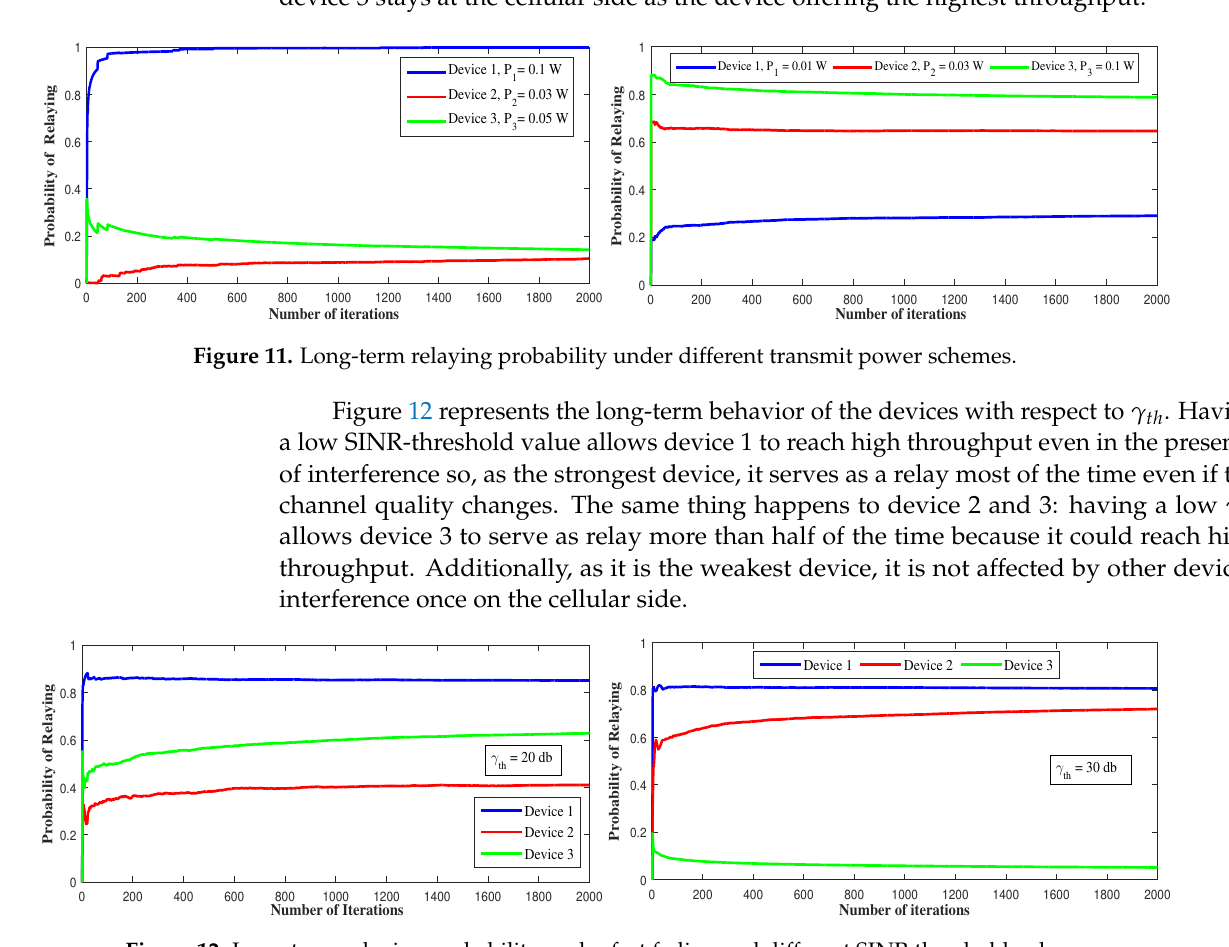
Figure 12. Long-term relaying probability under fast fading and different SINR threshold values.